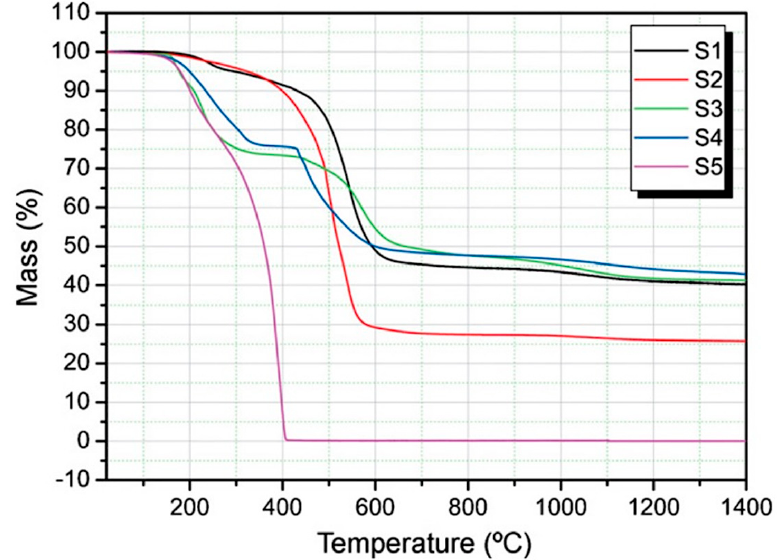
Figure 3. Thermogravimetric curves of polymers S1–S4 and S5 − (SiMe 2 − NCN) n − up to 1400 ◦ C [64]. S1–S4 represent polymers with the structures of − (PhSiR − NCN) n − , R = Phenyl(S1), Methyl(S2), H(S3), and Vinyl(S4). The ceramic compositions of pyrolyzed S1–S4 are Si 1 C 12.14 N 1.81 H 10.07 Cl 0.19 O 0.14 , Si 1 C 7.93 N 1.83 H 8.71 Cl 0.12 , Si 1 C 6.81 N 1.96 H 6.68 Cl 0.03 O 0.03 , and Si 1 C 8.75 N 1.37 H 8.63 Cl 0.54 O 0.08 , respectively.